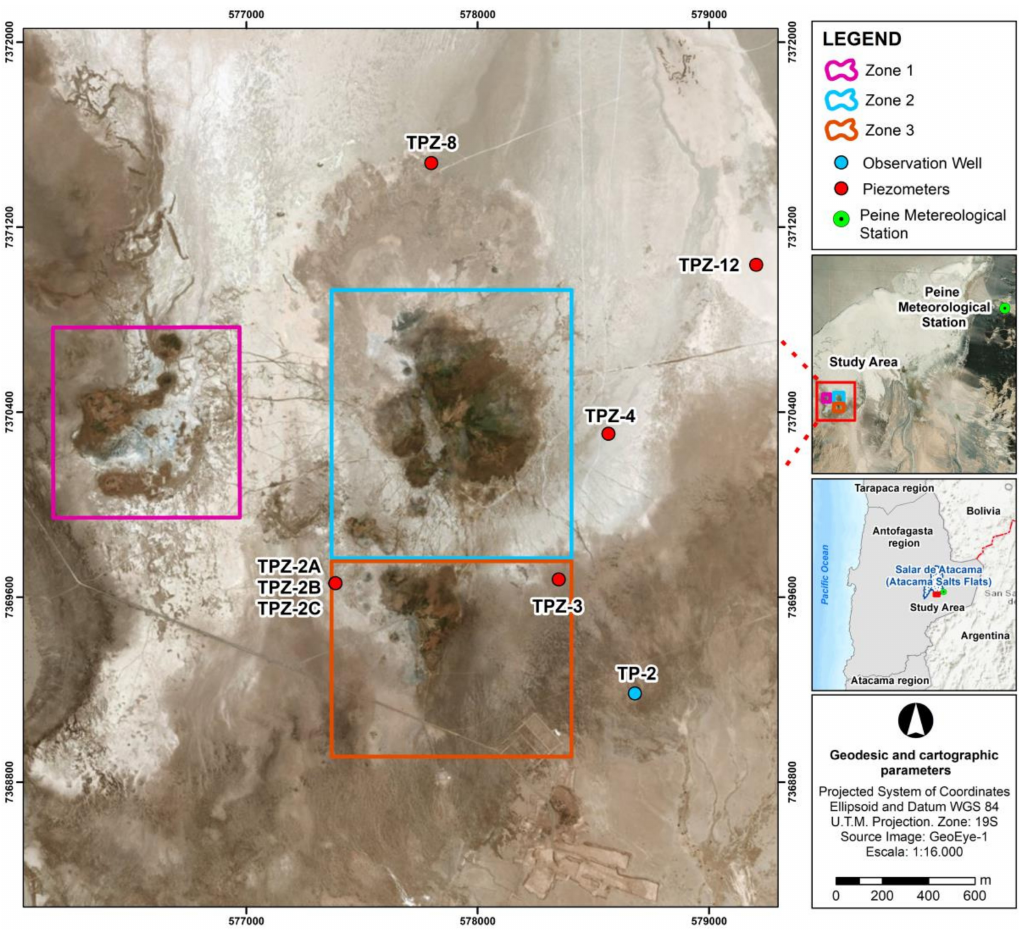
Figure 1. Position of the salt meadows zones of Tilopozo associates to three upwelling of water (1–3), located to the south of the Salar de